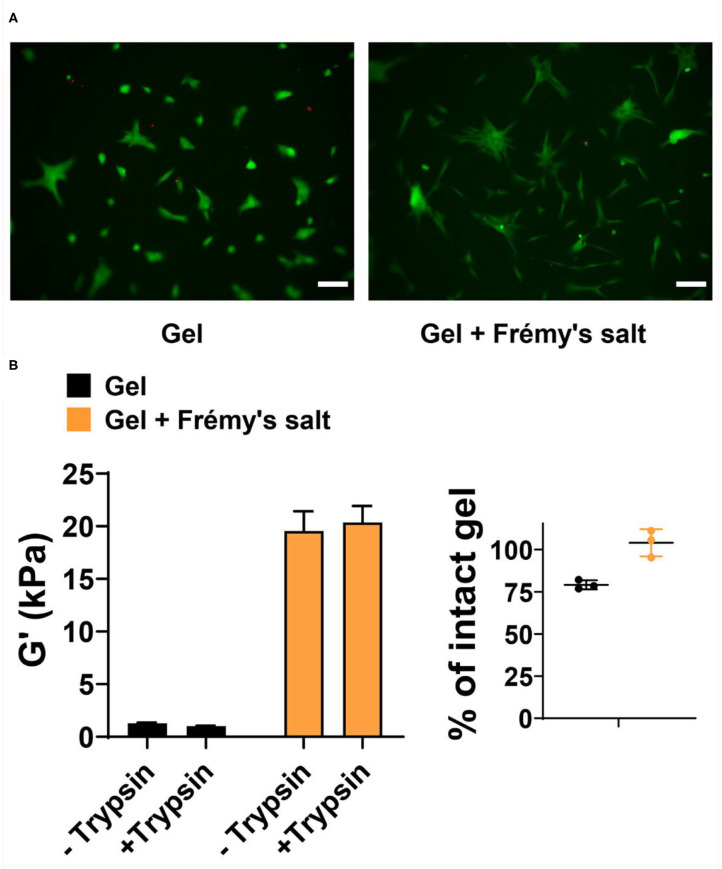
(A) Live/Dead assay of human dermal fibroblasts 48 h after being seeded onto 1 wt% tyrosine-gels untreated or treated with Frémy's salt (left and right panels, respectively). In live cells enzymatic conversion of non-fluorescent calcein-AM to calcein produce green fluorescence, whereas dead cells are labeled with ethidium homodimer-1 and fluoresce red. Scale bar is 100 μm. (B) Degradation of Frémy's salt-treated or untreated gels by trypsin. Rheological measurements were performed on 1 wt% gels following 2 days of incubation with trypsin or buffer as a control. Percentage of intact gel was calculated by dividing the G′ value of trypsin treated gel with the average of untreated control gels. Individual values of trypsin-treated gels are plotted with the mean and standard deviation.